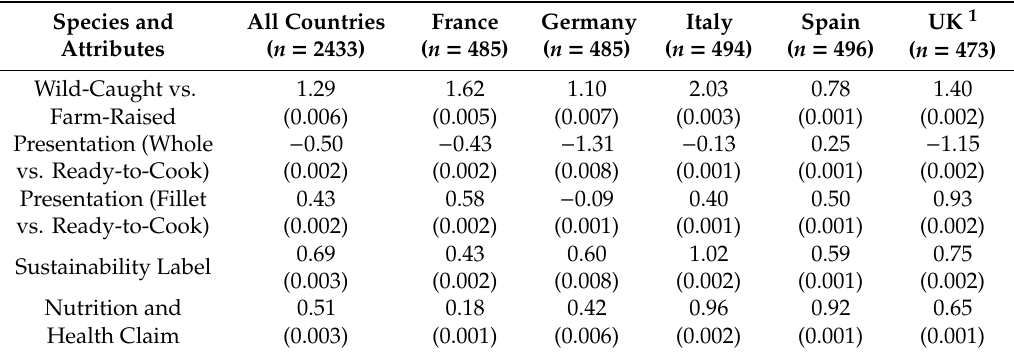
Table 6. Willingness to pay (WTP) estimates in € / kg (mean values, Monte Carlo standard error in parenthesis) of Mixed Logit (ML)